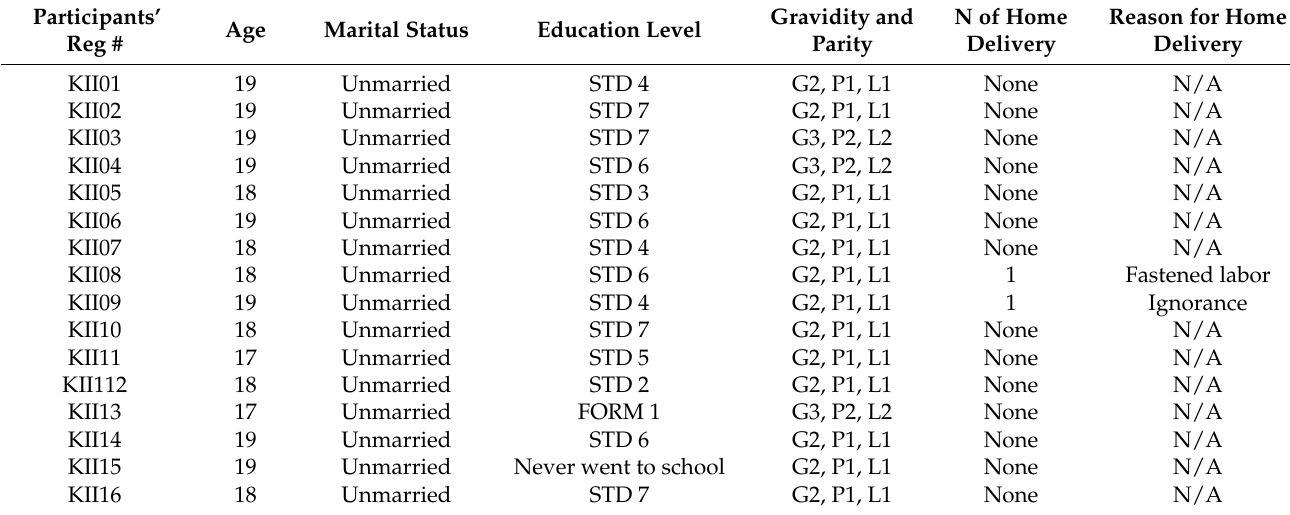
Table 2. Socio-demographic characteristics of the study participants.